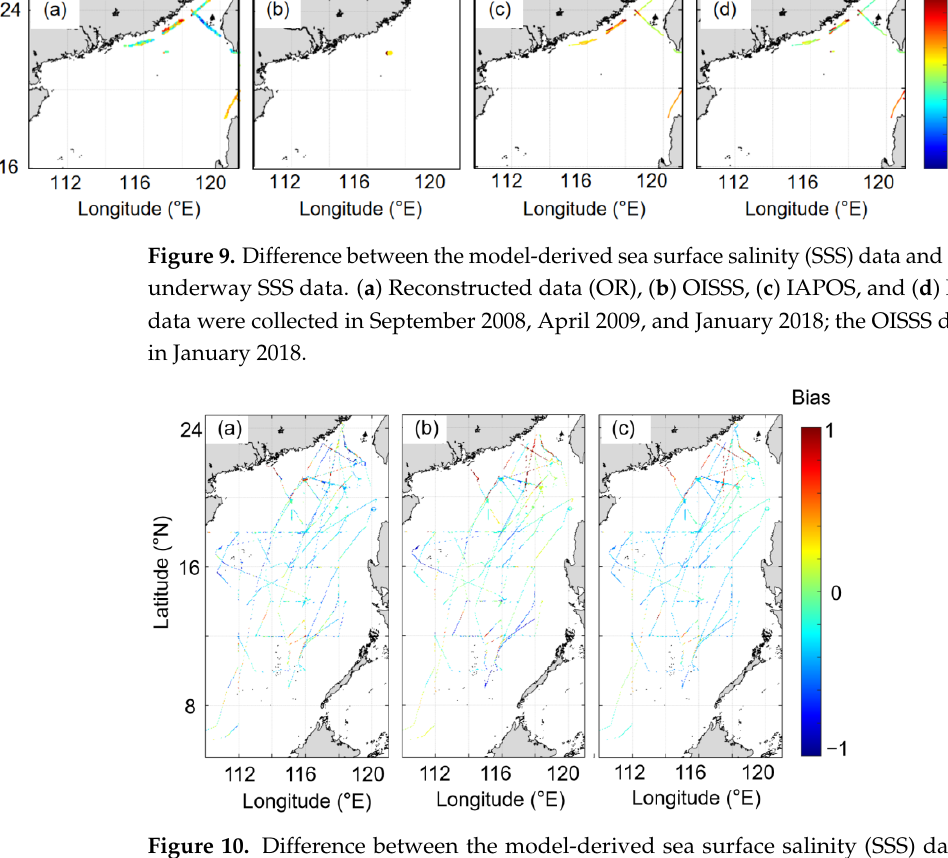
Figure 10. Difference between the model-derived sea surface salinity (SSS) data and concurrent underway OB_B data. ( a ) Reconstructed data generated in the present study, ( b ) OISSS, and ( c ) MUL. The IAPOS data are only available from 1940 to 2018 and were not used in this comparison.